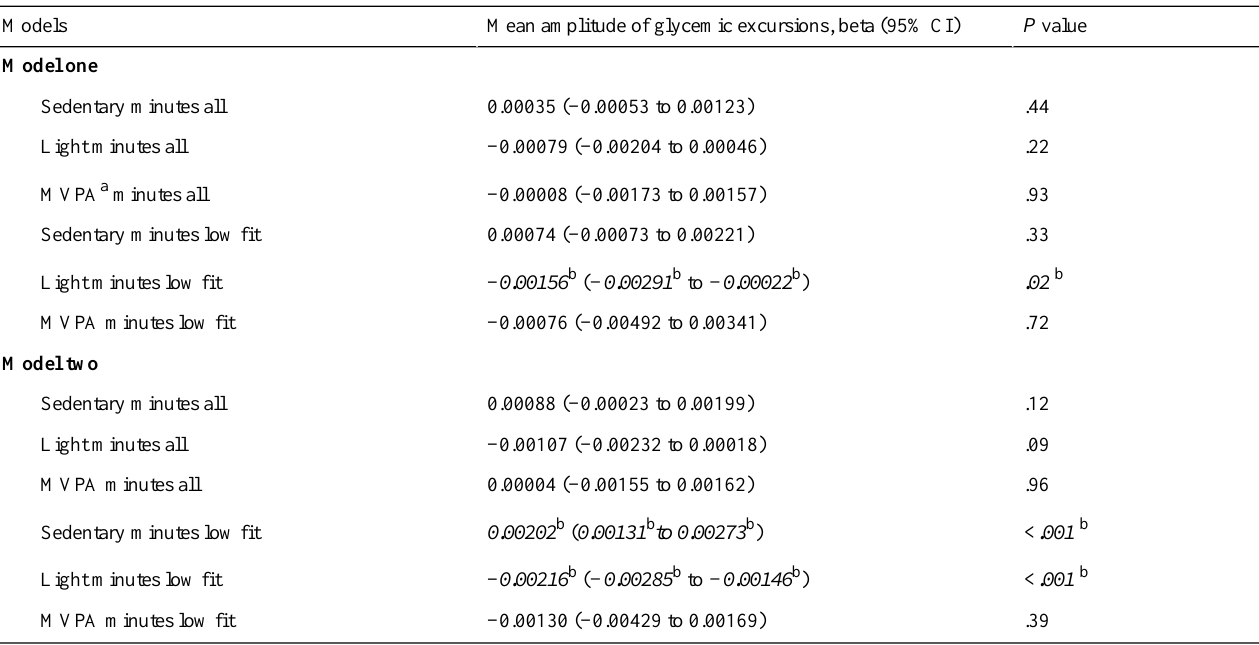
Table 5. Associations between physical activity and mean amplitude of glycemic excursions for the whole sample and for the low fitness group. Model one represents a univariable association, and model two is adjusted for wear minutes, age, sex, and percentage body fat.